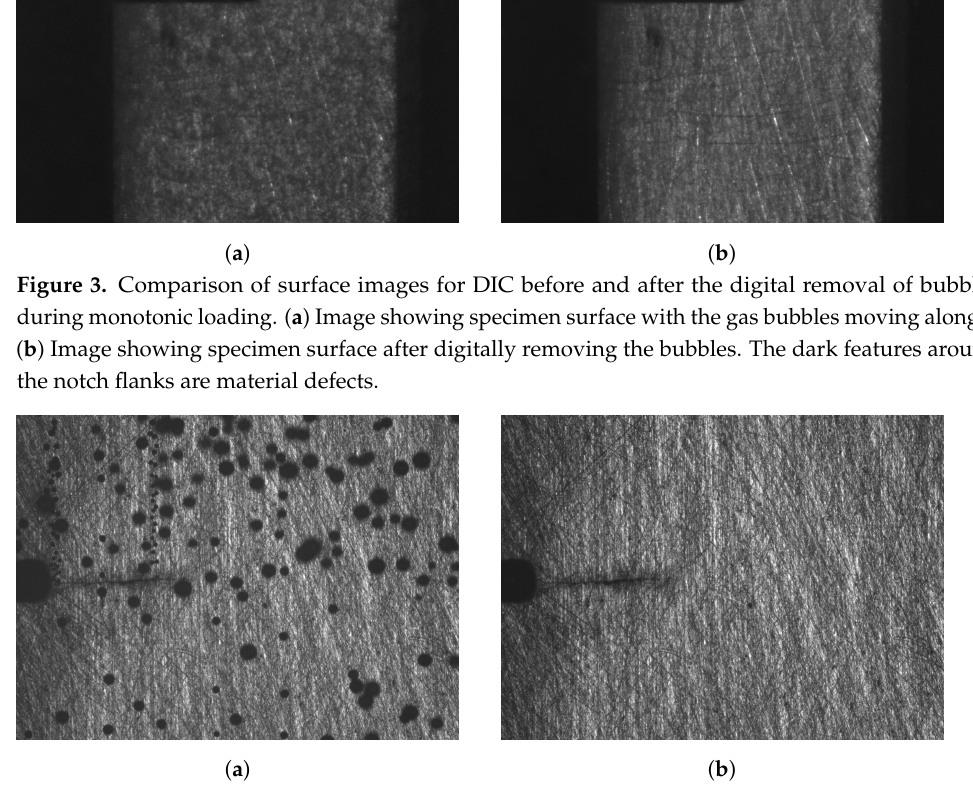
Figure 4. Comparison of surface images for DIC before and after the digital removal of bubbles for cyclic testing. ( a ) Image showing specimen surface with the gas bubbles moving along it during cyclic testing. ( b ) Image showing specimen surface after digitally removing the bubbles during cyclic